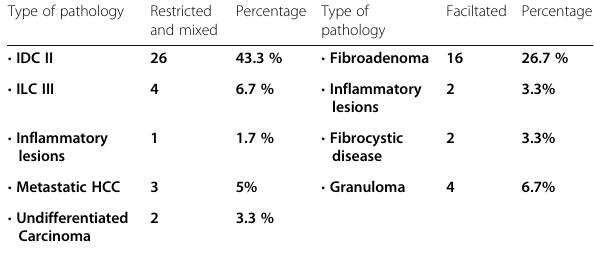
Table 3 Distribution of the Pathological characterization amoung the studies group patients Type of